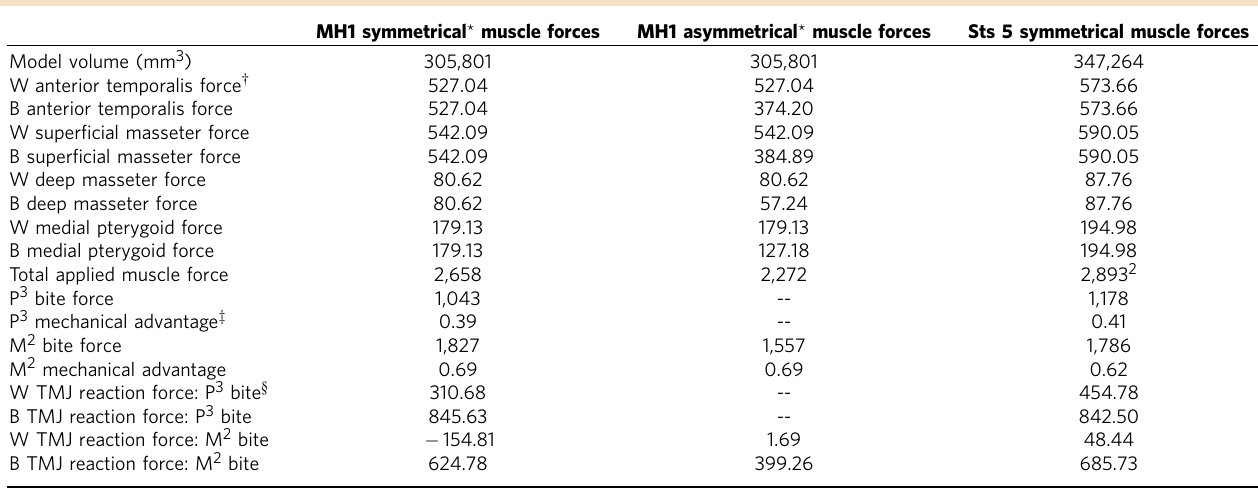
Table 1 | Force inputs and